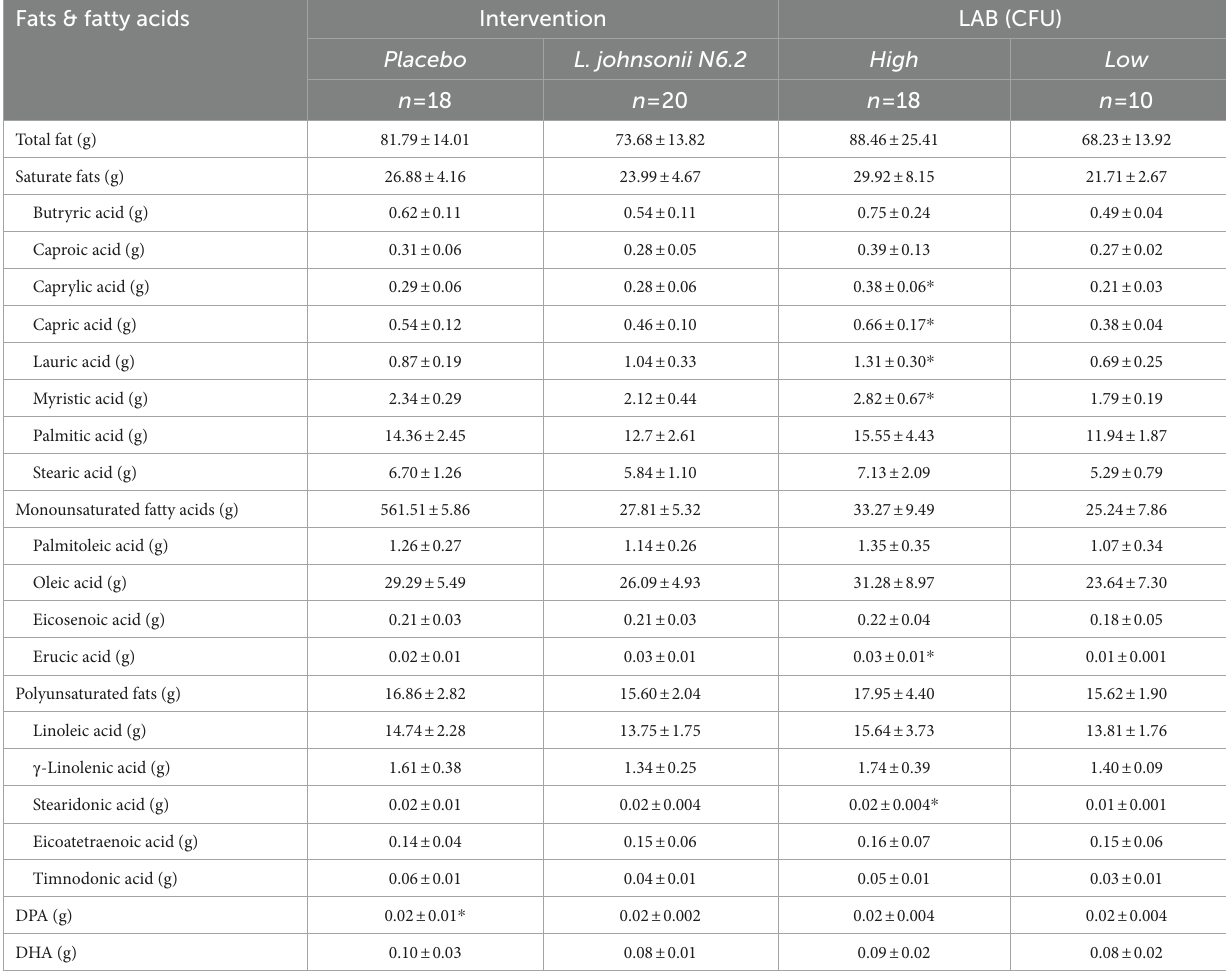
TABLE 2 Habitual intake represented as adjusted average intake of all measured fatty acids, mean (SD). * p < 0.05. Fats & fatty acids